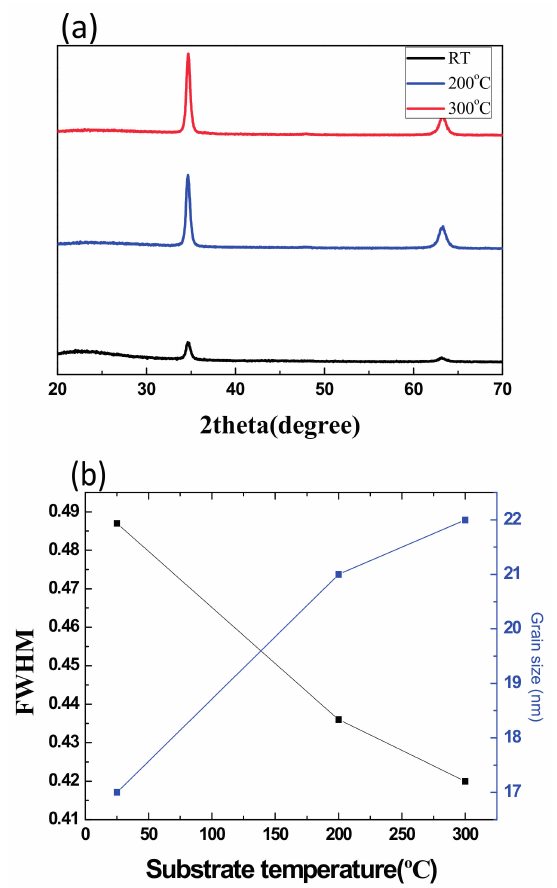
Figure 2. ( a ) The X-ray diffraction (XRD) measurement; ( b ) FHWM and grain size of AZO thin film deposited in room temperature, 200, and 300 ◦ C.